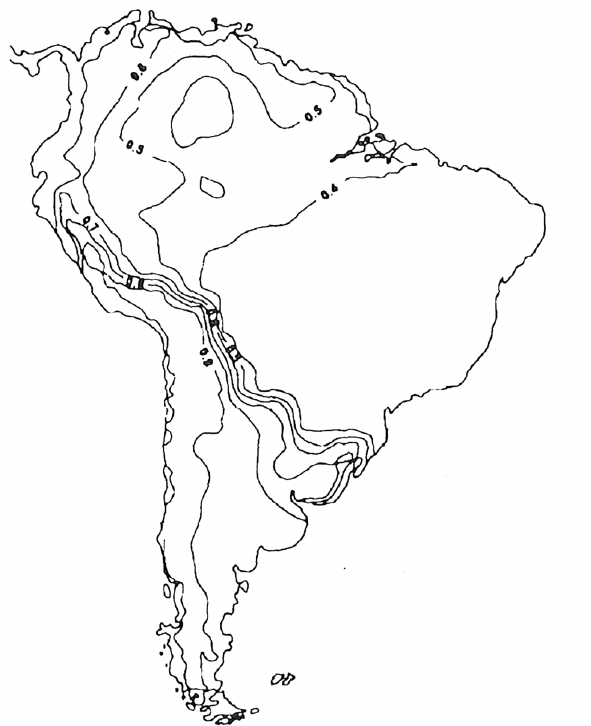
Fig. 6. Spatial patterns of variation in the environmental resistance separating the Neotropical region s.str. and the Andean region (see main text) (from Morrone